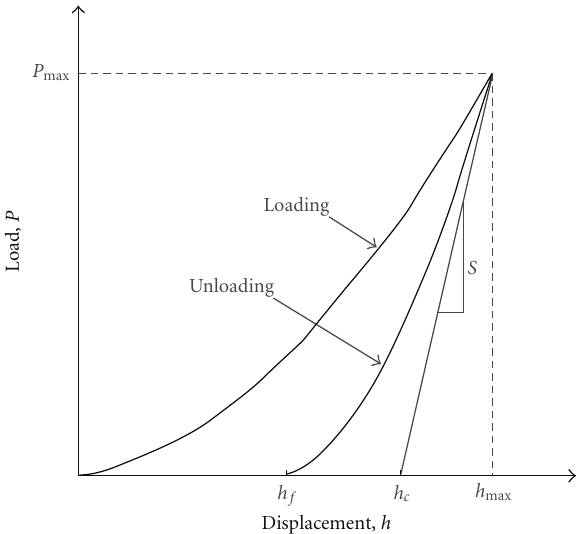
Figure 8: A typical load-displacement curve during a loading- unloading cycle where h max is the maximum indenter displacement at peak indentation load P max , S is the initial unloading slope of the load-displacement curve, and h c is the contact